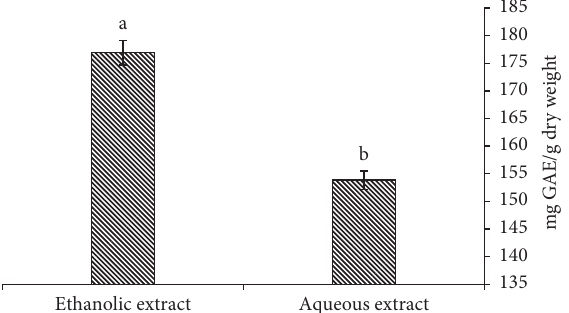
Figure 1: Phenolic contents of pomegranate peel extracts. Different letters on the bars indicate significant differences ( p < 0 . 05 )